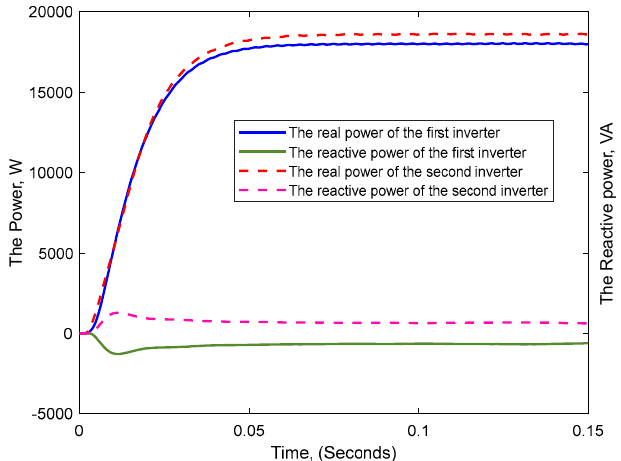
Figure 11. The active and reactive power of both inverters.